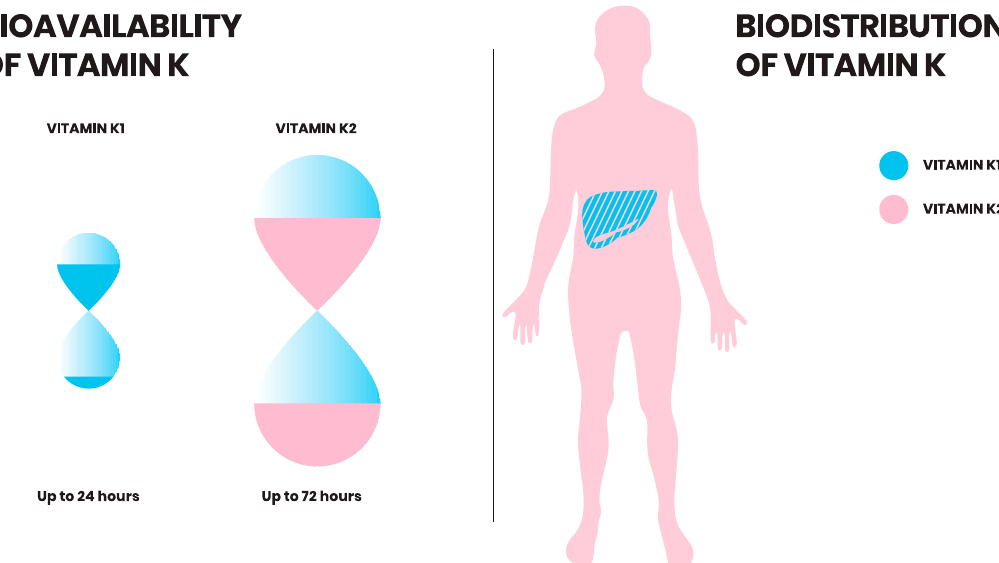
Figure 2. Bioavailability and biodistribution of vitamin K. Vitamin K2 has a longer half-life in the circulation than vitamin K1. While vitamin K1 is retained and exerts its function in the liver, vitamin K2 is redistributed to the circulation and (extra-)hepatic tissues.